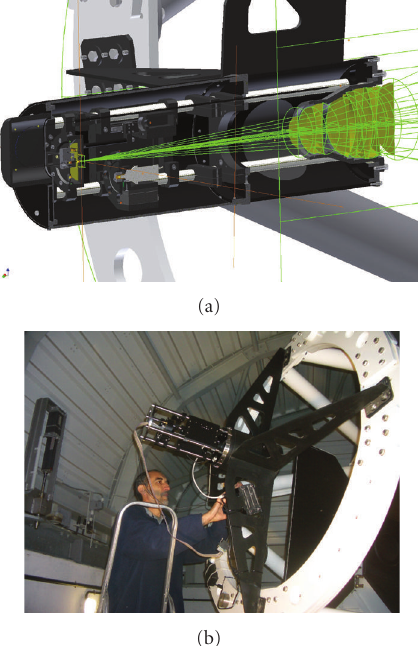
Figure 5: Design and installation of STELLA-II’s prime focus unit. (a) The CAD drawing shows the reflected beam through the five- lens corrector optics (right), an ADC, and a fiber viewing unit. (b) Emil Popow during installation of the unit in the prime